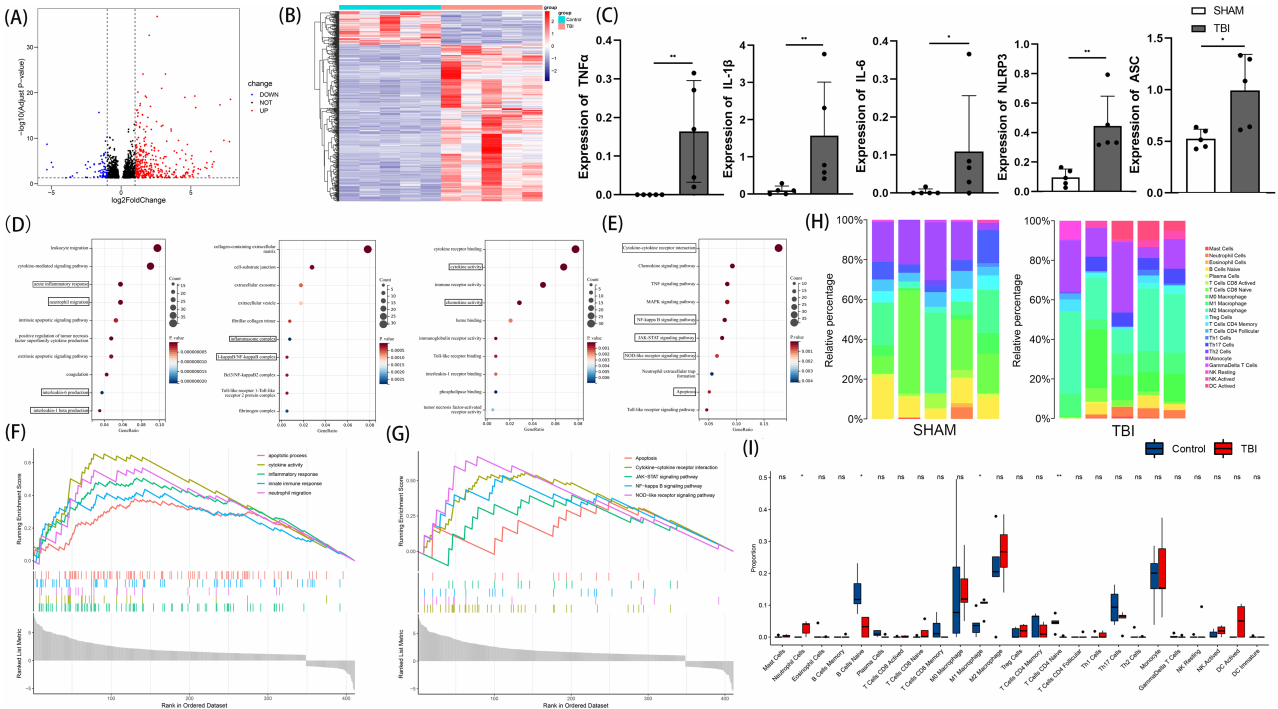
Figure 1. Gene expression analysis for TBI and control mice. Volcano plot of differential analysis ( A ). Heatmap of differential analysis ( B ). Comparison of TNF- α , IL-1 β , IL-6, NLRP3, and ASC expression between TBI group and control group ( C ) (n = 5, Kruskal-Wallis test). Bubble chart of BP, CC, and MF analysis ( D ). Bubble chart of KEGG analysis ( E ). Enrichment plots for GO and KEGG items from gene set enrichment analysis (GSEA) ( F , G ). Heatmap of immune infiltration in sham and TBI groups ( H ). Violin plot of immune infiltration in sham and TBI groups ( I ). All data are shown as mean ± SD. * p < 0.05, ** p <